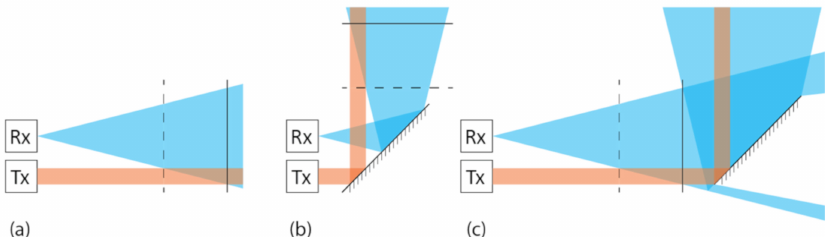
Figure 1. Diagrams of different areas of operation for light-based ToF distance measuring devices are shown for ( a ) direct method, ( b ) redirected method, where reflecting surface is entirely within the ranging device’s dead zone, and ( c ) for when the reflecting surface is located beyond the ranging device’s dead zone. Boxes marked Rx and Tx represent light transmitters (lasers) and receivers (photodiodes), respectively. The system’s dead zone ranges from the transmitter/receiver to the dashed line, and the partially dead zone extends up to the solid line.